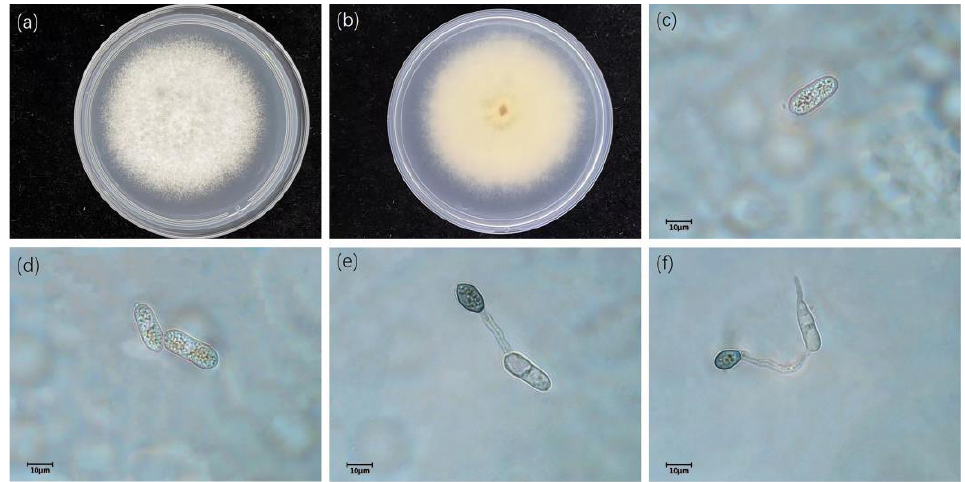
Figure 5. Colletotrichum siamense (CQFJ6-3). ( a ) Colony on PDA. ( b ) Reverse side of the colony on PDA. ( c , d ) Conidia. ( e , f ) Appressoria. Scale bars = 10 µm.